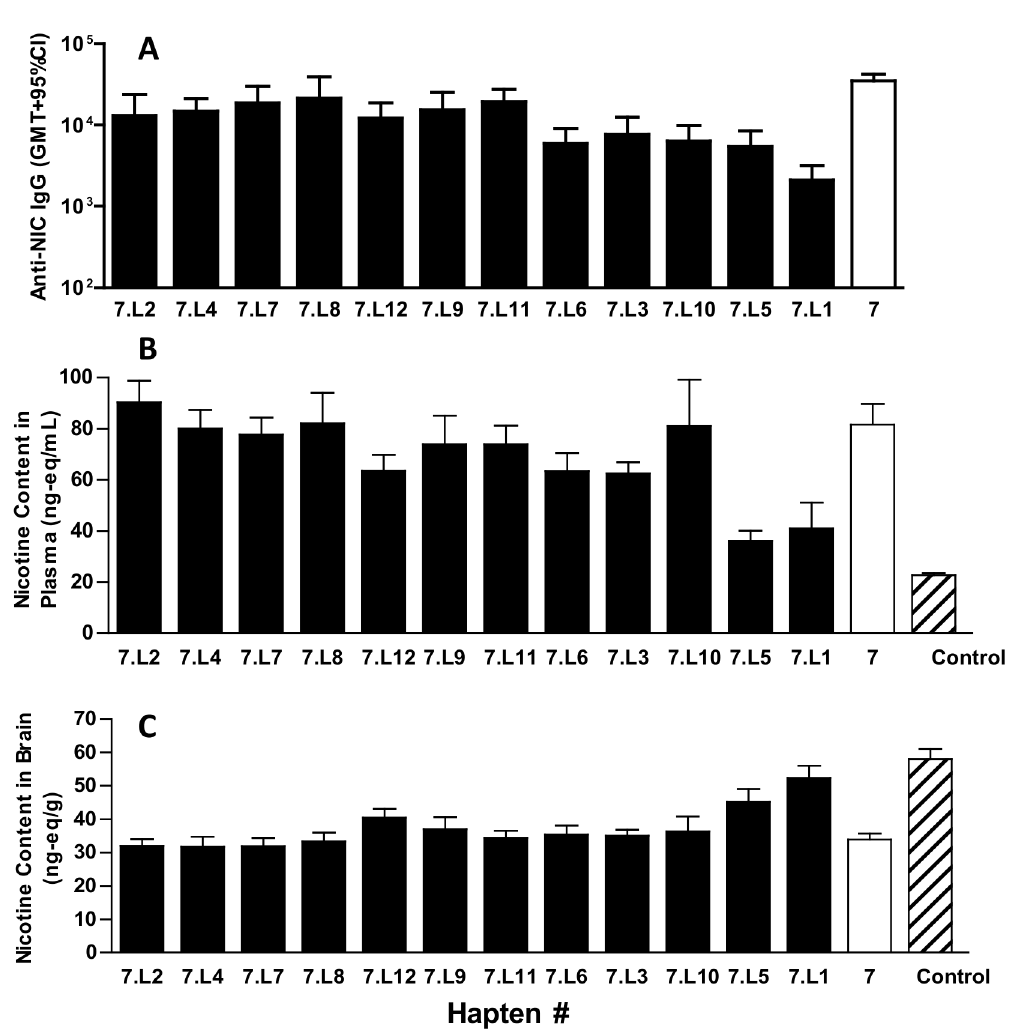
Figure 10. Anti-nicotine antibody titer and function in mice. Panel A: BALB/c mice (n = 12/gp) were immunized by IM injection with 10 µg of different nicotine Hapten-DT conjugates adjuvanted with Al(OH) (40 µg Al 3+ ) + CpG 24555 (50 µg) on days 0, 28 and 3 42. Plasma was collected on day 54 and anti-nicotine antibody levels determined by ELISA (Panel A). On day 56 animals received an IV injection of 3 H-nicotine (0.05 mg/kg) and plasma and brains collected. Panel B shows nicotine levels in plasma (ng-eq/mL), and Panel C shows nicotine levels in brain